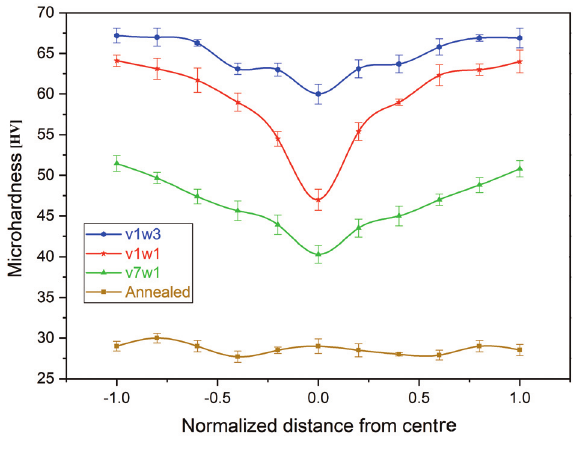
Fig. 4. Hardness evolution in the cross-section of HPTE speci - Table 2. Results of microstructure and hardness testing of the samples